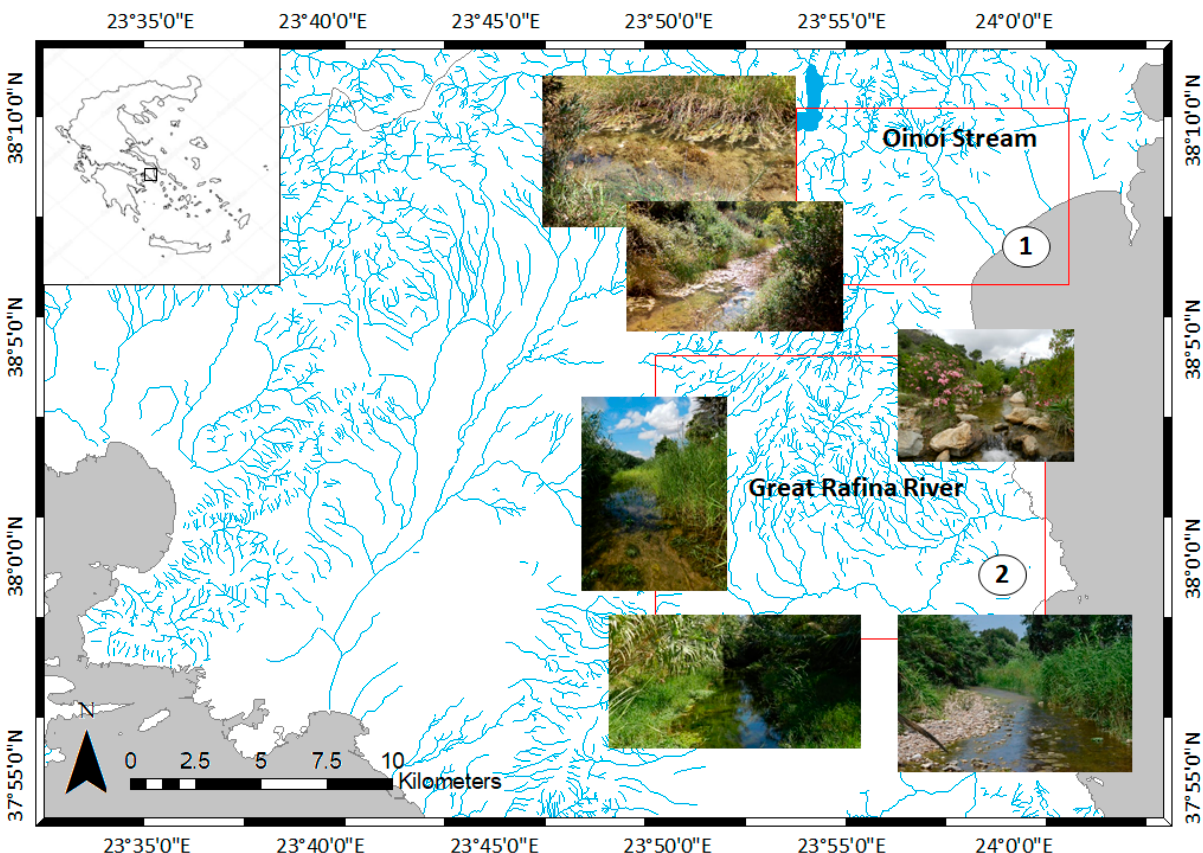
Figure 1. Study area. The Oinoi Stream and the upper Great Rafina River (Lykorema Stream), Attica, Greece, in which 124 vegetated microhabitats were sampled in spring and summer 2021.